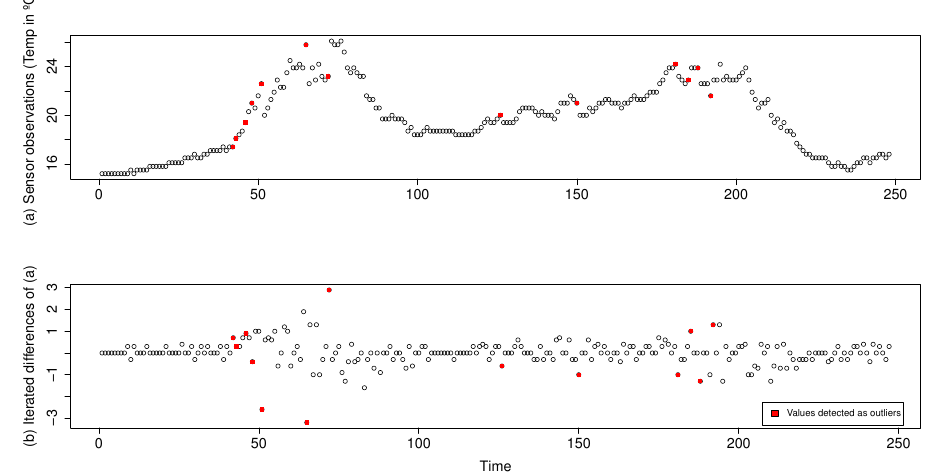
Figure 5. ( a ) shows a series of 250 samples from a temperature sensor and ( b ) represents the iterated differences of the samples of the chart ( a ). In red, we can see the outliers considered by the ARIMA model (observations were taken every 5